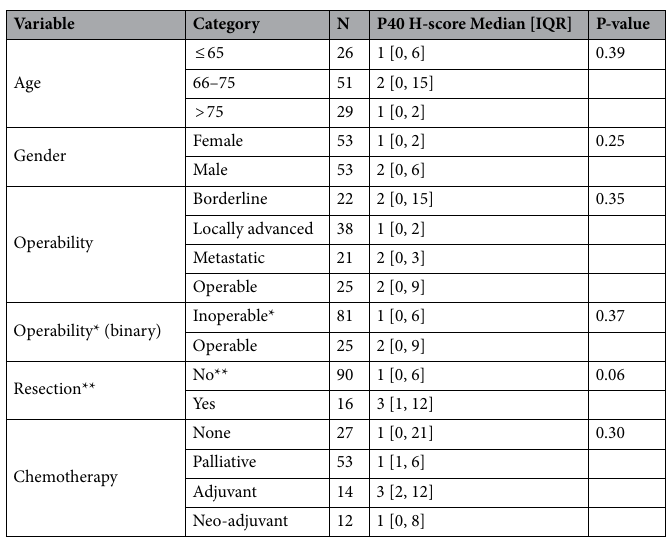
Table 2. Associations between demographic/treatment factors and FNB p40 H-score. *Inoperable combines patients with borderline, locally advanced and metastatic PDAC. **No resection includes all inoperable patients and patients who did not undergo an operation for reasons unrelated to PDAC.